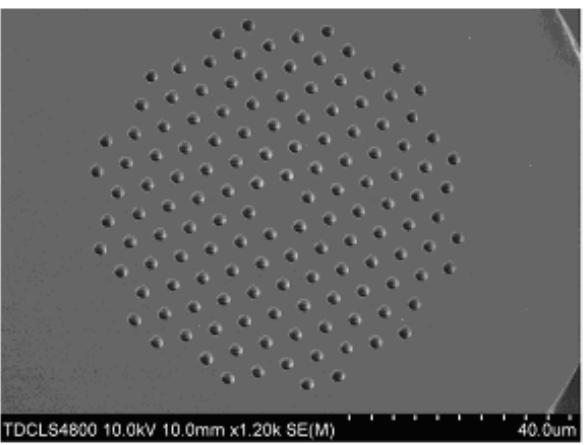
Figure 1. The image of LMA-8 cross section from field emission scanning electron